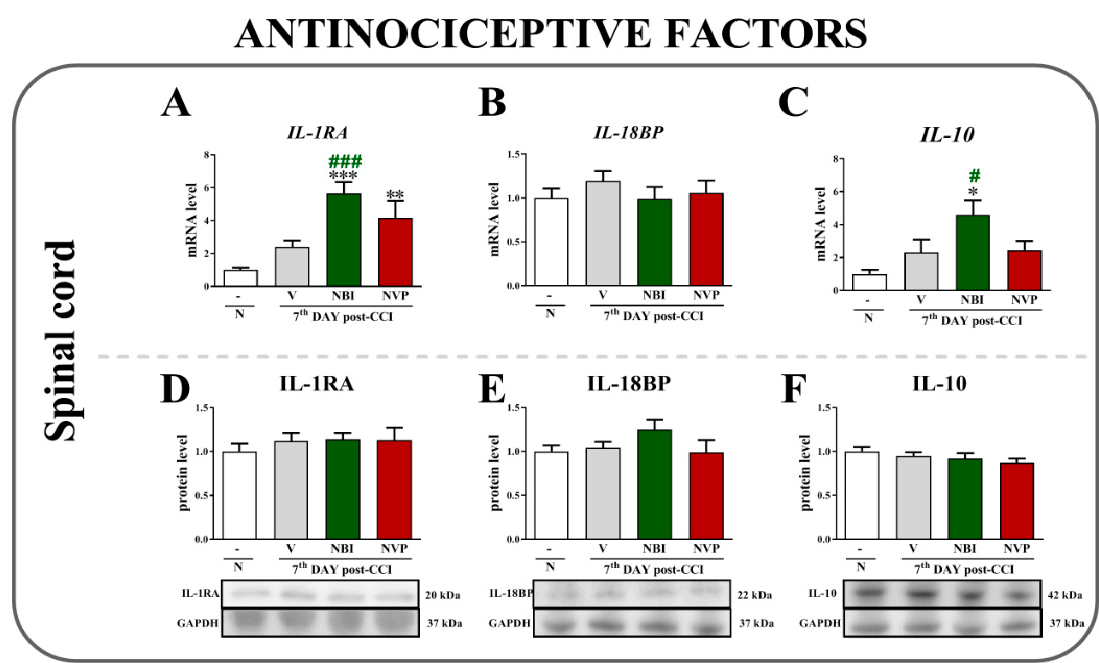
Figure 4. Comparison of the effects of repeated intrathecal ( i.t .) administration of (±)-NBI 74330 and NVP CXCR2 20 (10 µg/5 µL; each) on the mRNA ( A – C ) and protein ( D – F ) levels of select antinociceptive factors (IL-1RA, IL-18BP, and IL-10) in the spinal cord ( A – F ) on the 7th day after chronic constriction injury in rats. The RT-qPCR and Western blot data are presented as the means ± SEM (4–9 rats per group for RT-qPCR and 5–7 for Western blot). The results were evaluated using one-way ANOVA followed by Bonferroni’s test. * p < 0.05, ** p < 0.01, and *** p < 0.001 for the comparison of naive animals with all groups. # p < 0.05 and ### p < 0.001 for the comparison of vehicle-treated animals with all groups. Abbreviations: naive, N; vehicle, V; (±)-NBI 74330, NBI; NVP CXCR2 20, NVP.